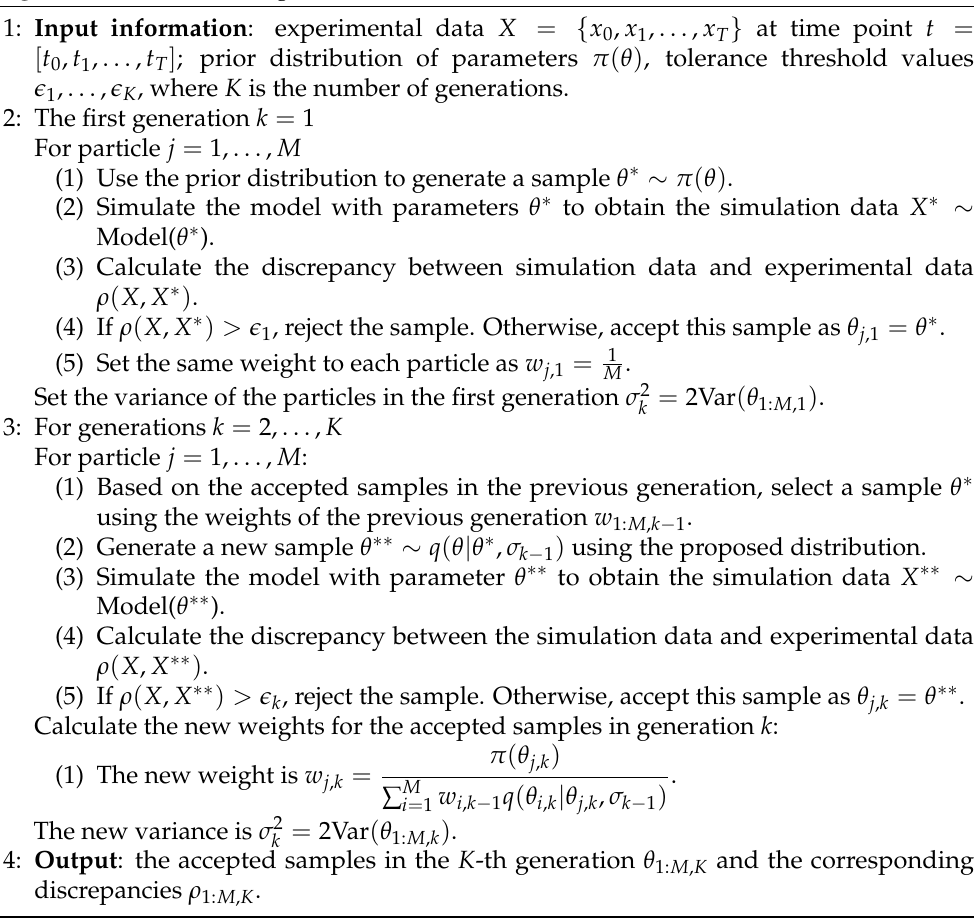
Algorithm 1 ABC-SMC